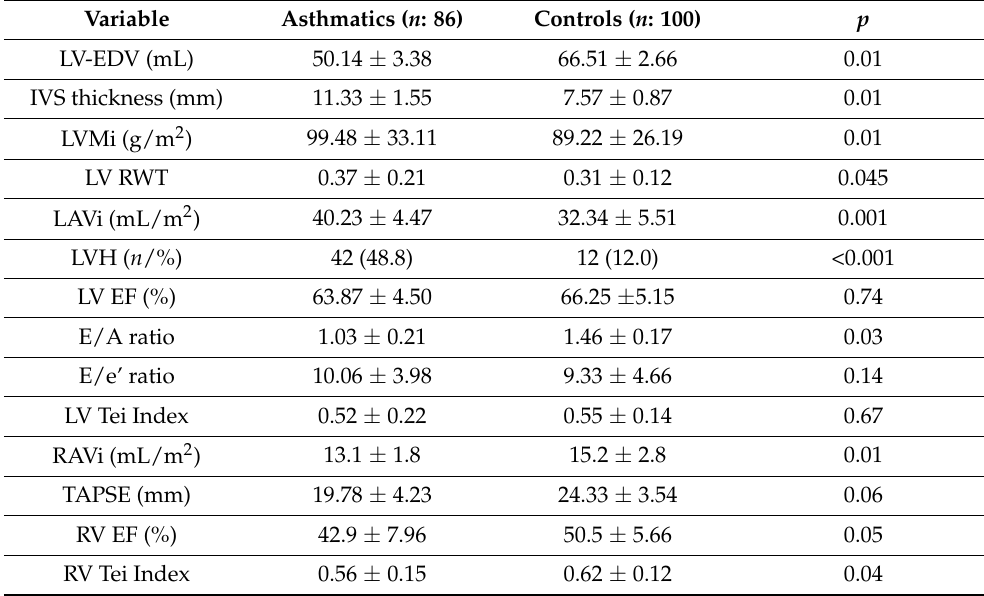
Table 2. Echocardiographic data of asthmatic vs. control subjects.